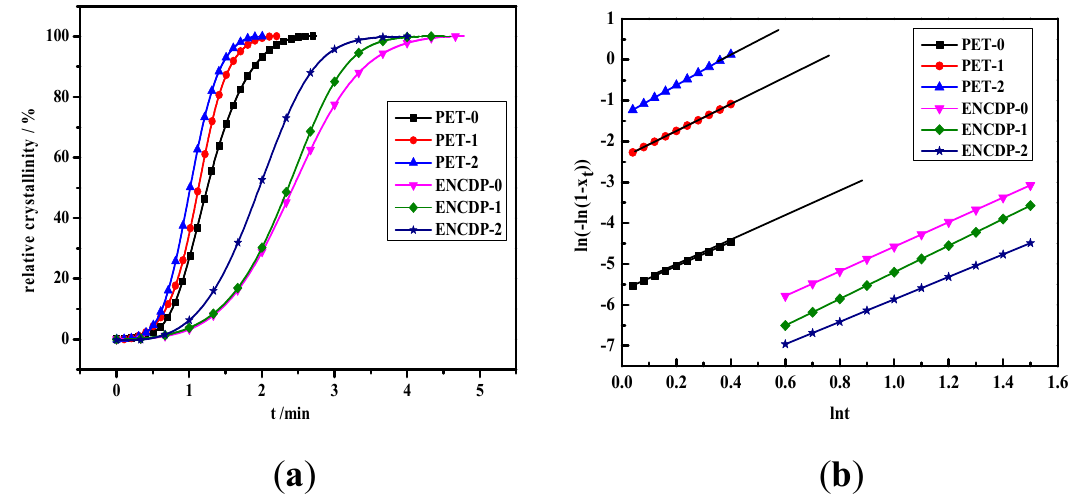
Figure 6. ( a ) The relative crystallinity versus time for the non-isothermal crystallization; ( b ) the Ln [ − Ln (1 − X t )] versus Lnt for the non-isothermal crystallization.